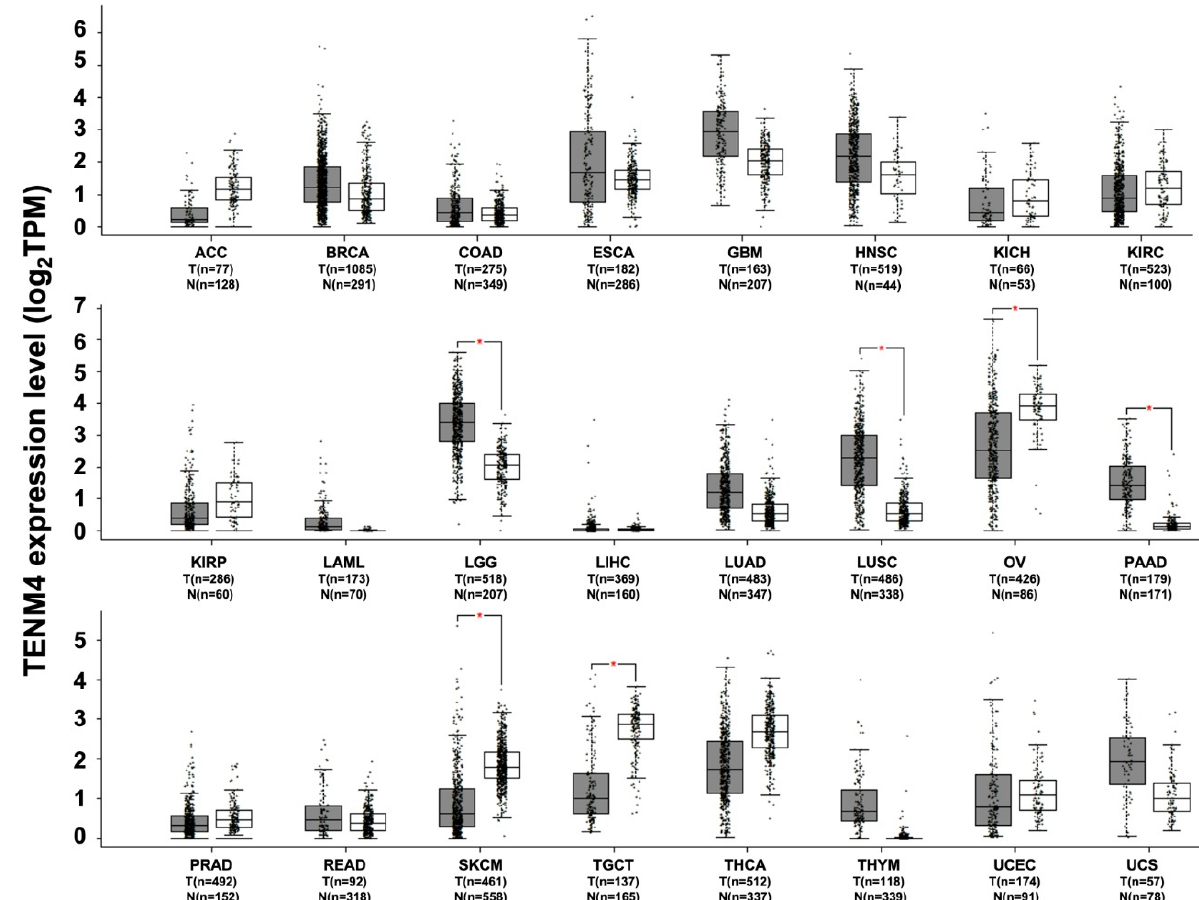
Figure 5. TENM4 expression in different datasets of tumors and normal samples. TENM4 expression level, shown as log2 of transcript per million mapped reads value, was analyzed from RNA sequencing data of tumors and normal samples from the TCGA and the GTEx projects, using a web standard processing pipeline [43]. Tumor (T) and normal samples (N) are represented in grey and white box plots, respectively, each dot representing a sample ( n = number of samples within the dataset). Statistical differential analysis was performed using the GEPIA default recommended parameters, one-way ANOVA, |Log2FC| ≥ 1 and p ≤ 0.01. Datasets description: ACC; Adrenocortical carcinoma. BRCA; Breast invasive carcinoma. COAD; Colon adenocarcinoma. ESCA; Esophageal carcinoma. GBM; Glioblastoma multiforme. HNSC; Head and neck squamous cell carcinoma. KICH; Kidney chromophobe. KIRC; Kidney renal clear cell carcinoma. KIRP; Kidney renal papillary cell carcinoma. LAML; Acute myeloid leukemia. LGG; Brain lower grade glioma. LIHC; Liver hepatocellular carcinoma. LUAD; Lung adenocarcinoma. LUSC; Lung squamous cell carcinoma. OV; Ovarian serous cystadenocarcinoma. PAAD; Pancreatic adenocarcinoma. PRAD; Prostate adenocarcinoma. READ; Rectum adenocarcinoma. SKCM; Skin cutaneous melanoma. TGCT; Testicular germ cell tumors. THCA; Thyroid carcinoma. THYM;